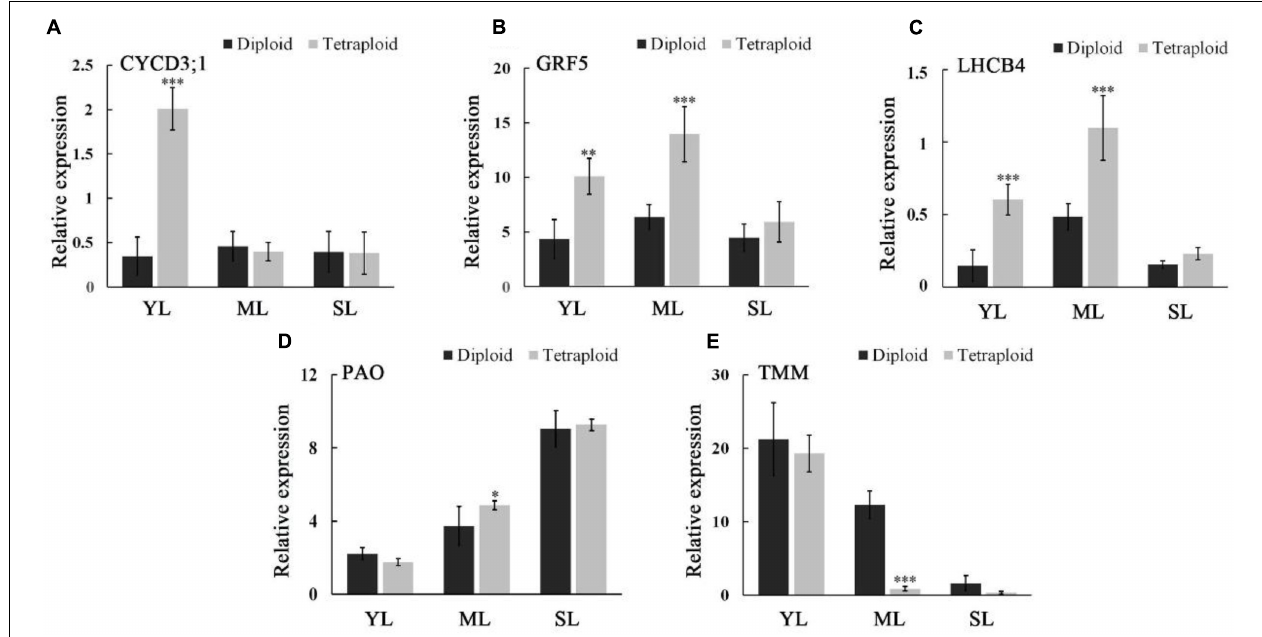
FIGURE 7 | Expressions of CYCD3;1 (A) , GRF5 (B) , LHCB4 (C) , PAO1 (D) , and TMM (E) were measured by real-time qRT-PCR in young leaves (YM), mature leaves (ML), and senescent leaves (SL) of diploids and tetraploids. ***for P ≤ 0.001, **for 0.001 < P ≤ 0.01, and *for 0.01 < P ≤ 0.05.